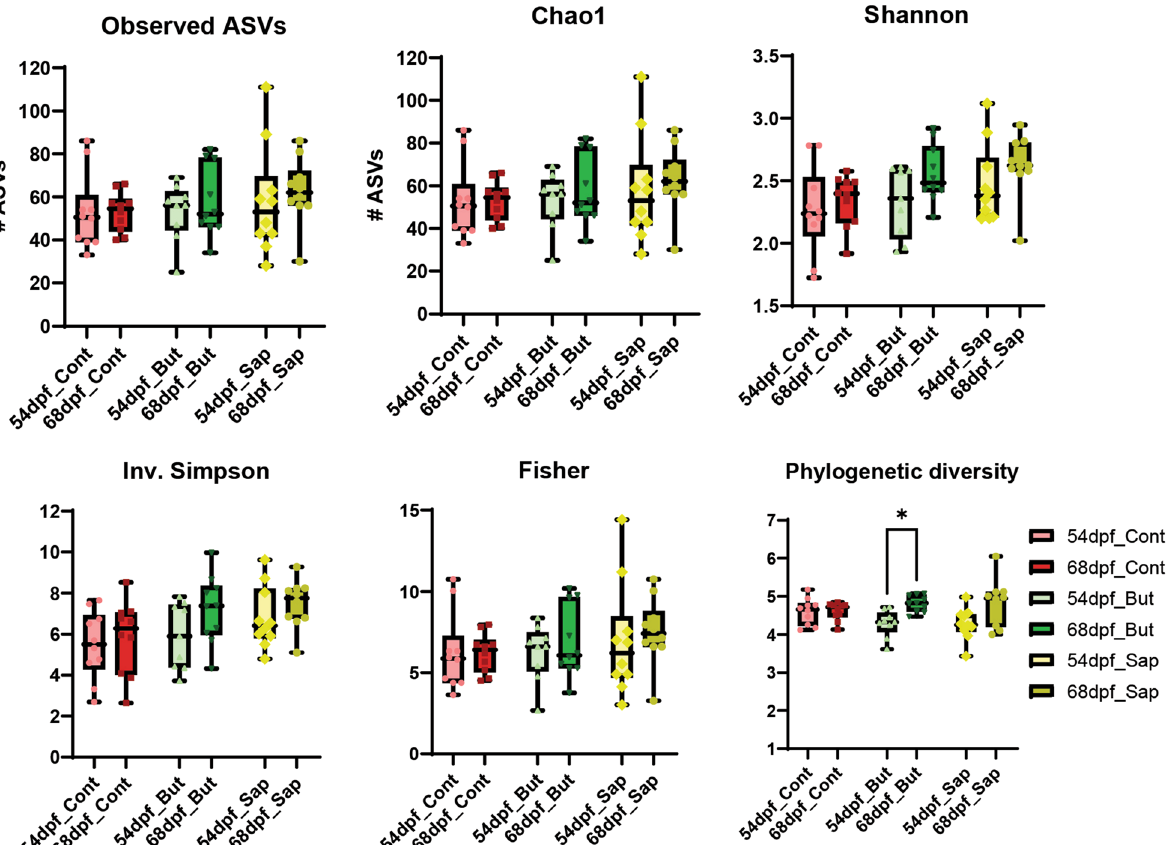
Fig. 3 Alpha-diversity indexes for richness (observed ASVs and Chao1) and for diversity (Shannon, Inverse Simpson, Fisher and Phylogenetic Diversity). * p 0.05, Ordinary one-way ANOVA after confirming normally distributed data by Shapiro–Wilk test. Whiskers: min. to max. shall all points ≤ with median